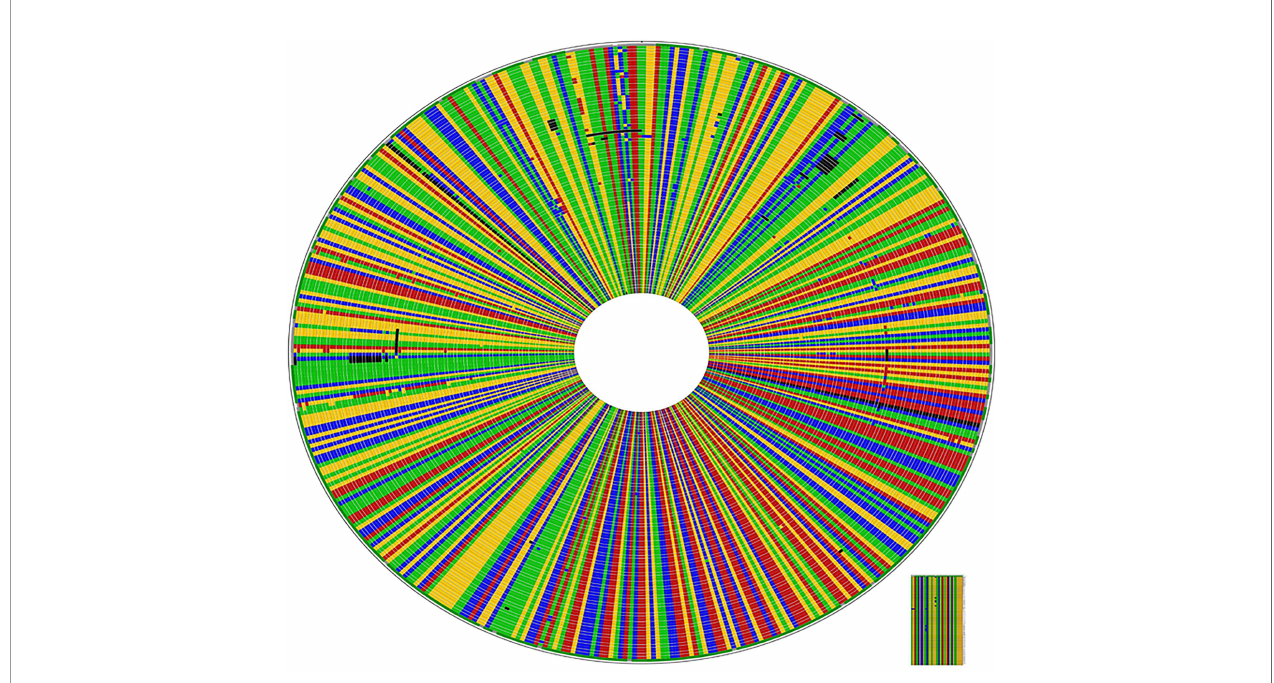
FIGURE 4 | High rate of conservation amongst Ethiopian Histoplasma capsulatum in ITS1-5.8s-ITS2 region: CLUSTAL W alignment of the 92 isolates including the 29 generated from this study. The sequences different from the consensus sequences are highlighted by a different color; dark colors indicate gaps.